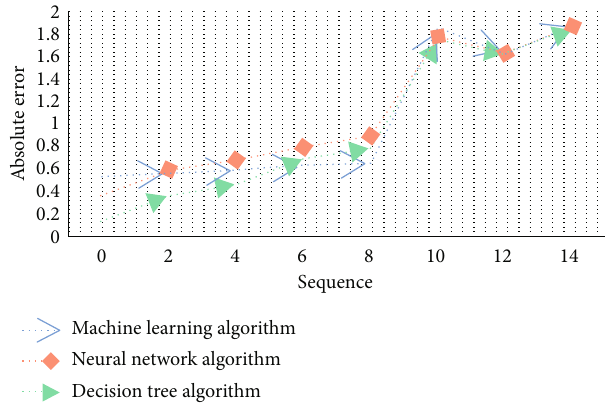
Figure 6: Comparison of average absolute error of three algorithms.